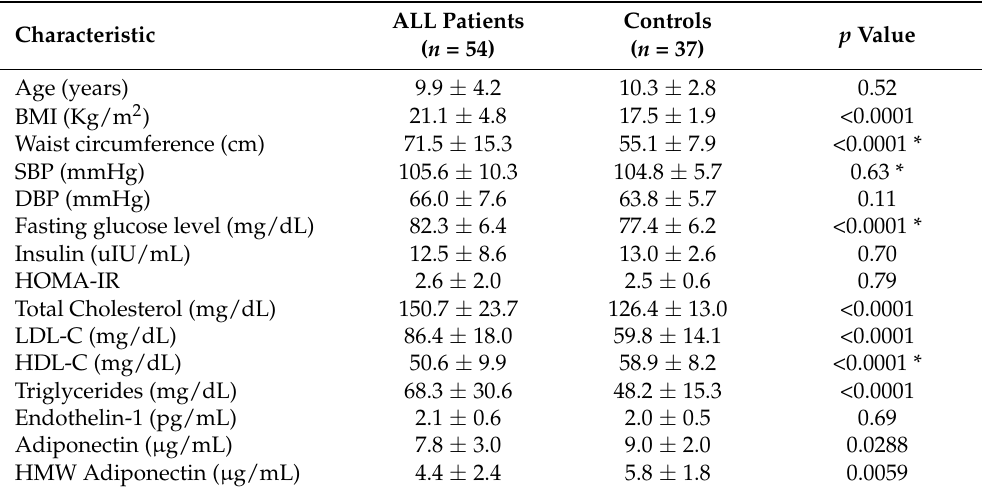
Table 1. Anthropometric, clinical, and laboratory characteristics of the study population and controls. ALL Characteristic